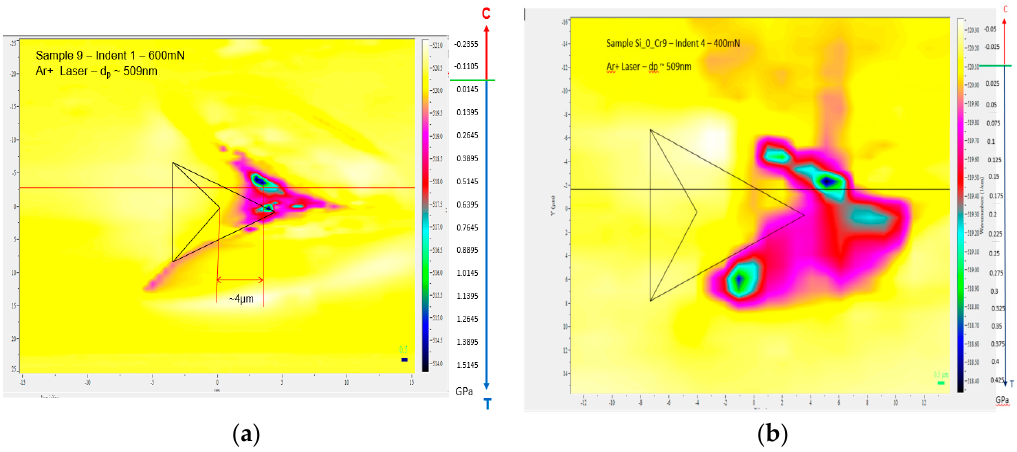
Figure 4. Micro-Raman maps of the stress around the indents shown in Figure 3 after annealing for 30 min at 1000 ° C. The Raman spectroscopy maps covers regions whose extent is: 30 μ m (X) by 50 μ m (Y) ( a ); and 30 μ m (X) by 32 μ m (Y) ( b ). Step size 0.5 μ m. The red and blue arrows indicate whether the stress is compressive (C) or tensile (T). The highest compressive stress is indicated by the yellow regions, while the greatest tensile strain is indicated by the black/blue regions.